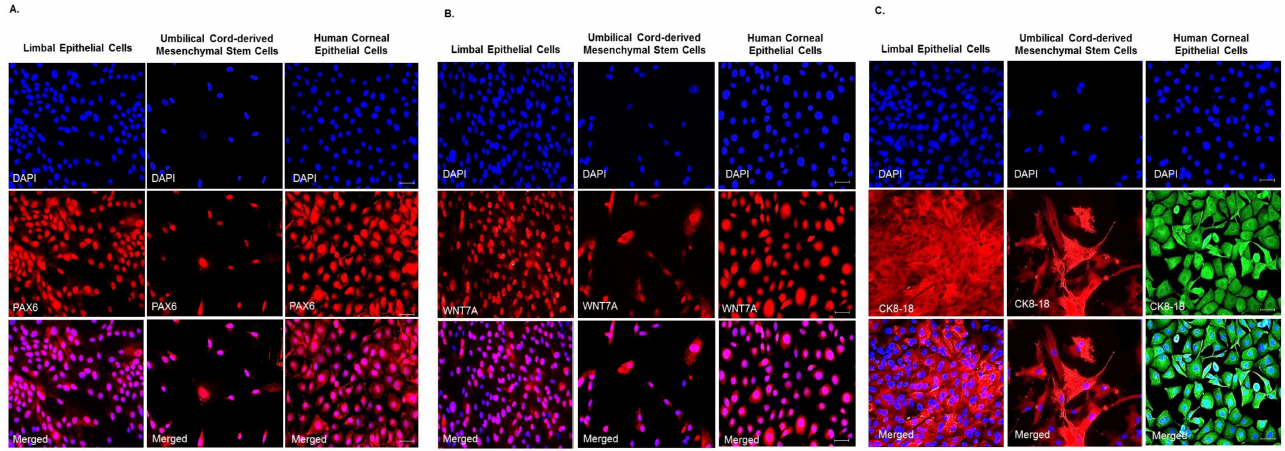
Figure 3. In vitro cultured human umbilical cord-derived mesenchymal stem cells (UC-MSCs) show endogenous expression of ( A ) PAX6, an ocular surface developmental marker [40] and a pleiotropic master regulator of eye development [41,42], ( B ) WNT7A, a key signaling molecule of the Wnt pathway which controls proliferation of human corneal epithelial stem cells [43], and ( C ) CK-8/18, an epithelial marker [44] under standard culture conditions. This indicates that the hUC-MSCs may possess inherent potential for corneal epithelial repair/regeneration. The human limbal and corneal epithelial cells were used as controls. The top panel shows DAPI staining, the middle panel shows antigen specific staining and the lower panel shows merged image of both DAPI and antigen specific staining in each of the three cell types, respectively. The specificity of the staining was determined by suitable isotype controls (data not shown). Bar size: 50 µ